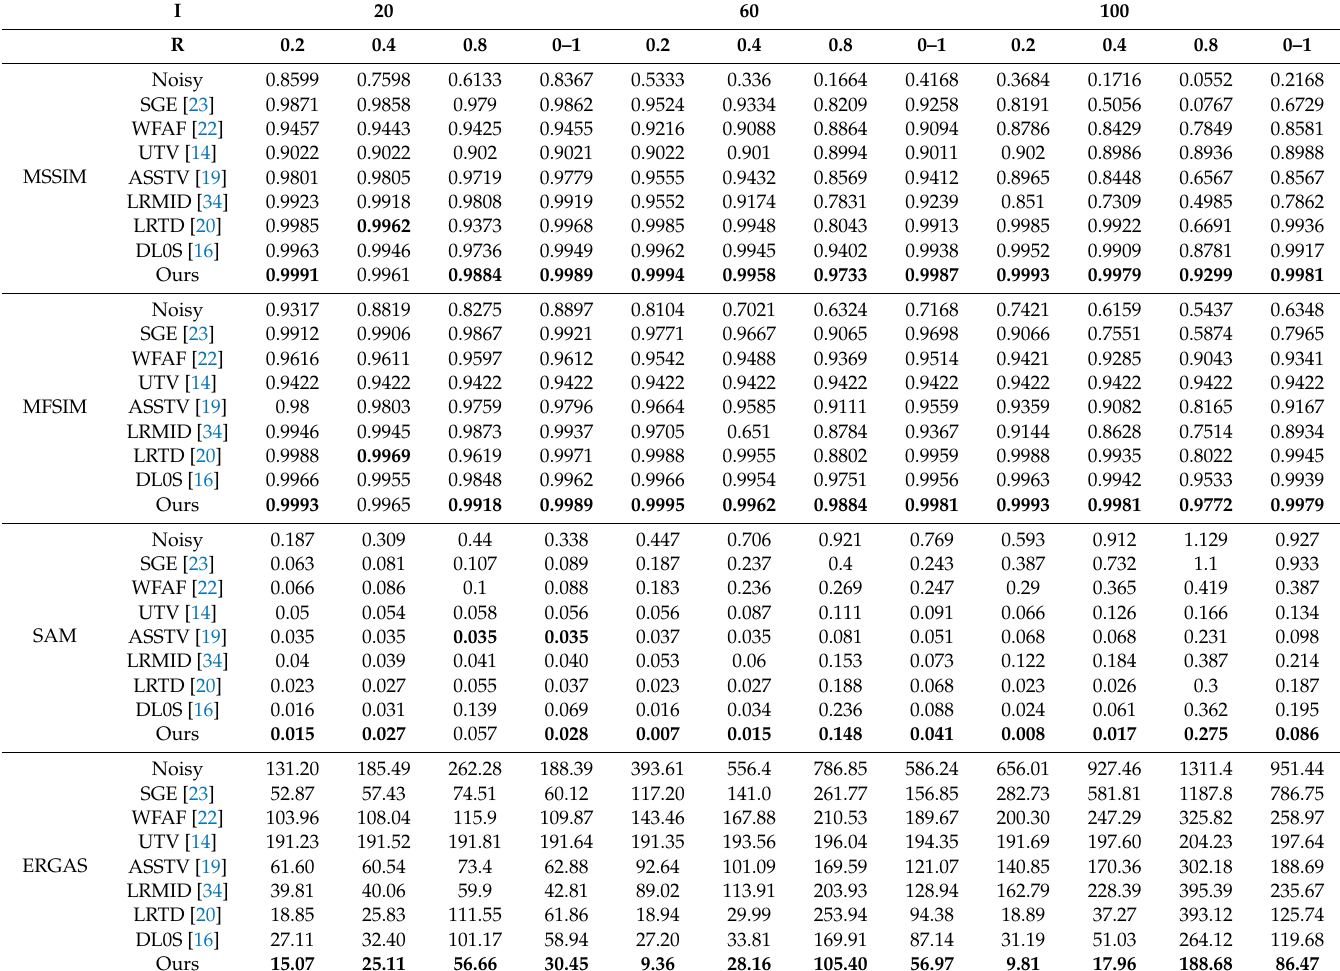
The boldface digits in Table 2 represent the best